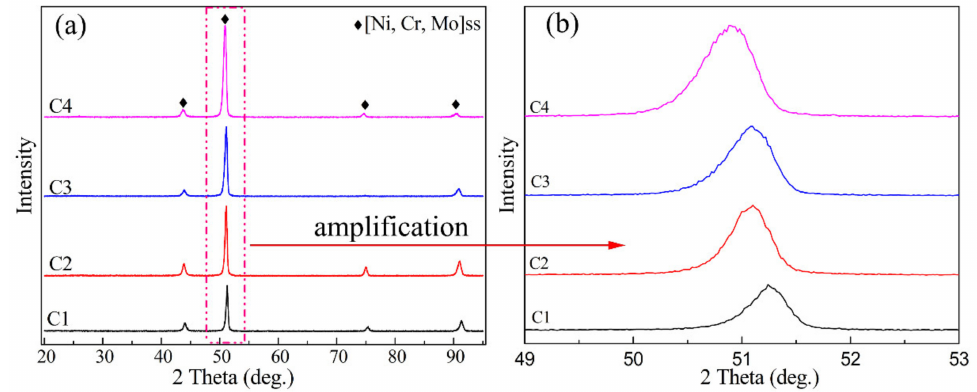
Figure 3. ( a ) XRD patterns and ( b ) partially enlarged patterns of C1–C4